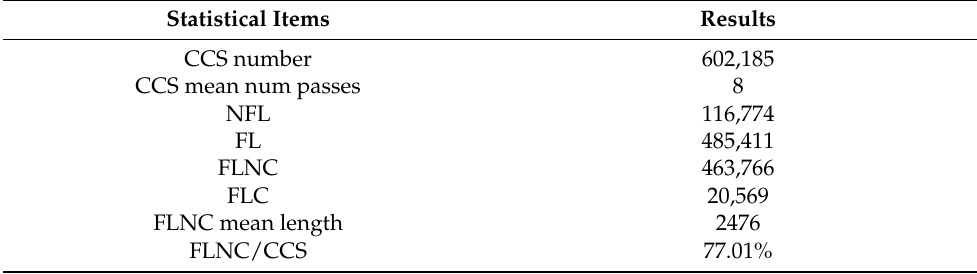
Table 1. Statistical results of full-length transcript classification.